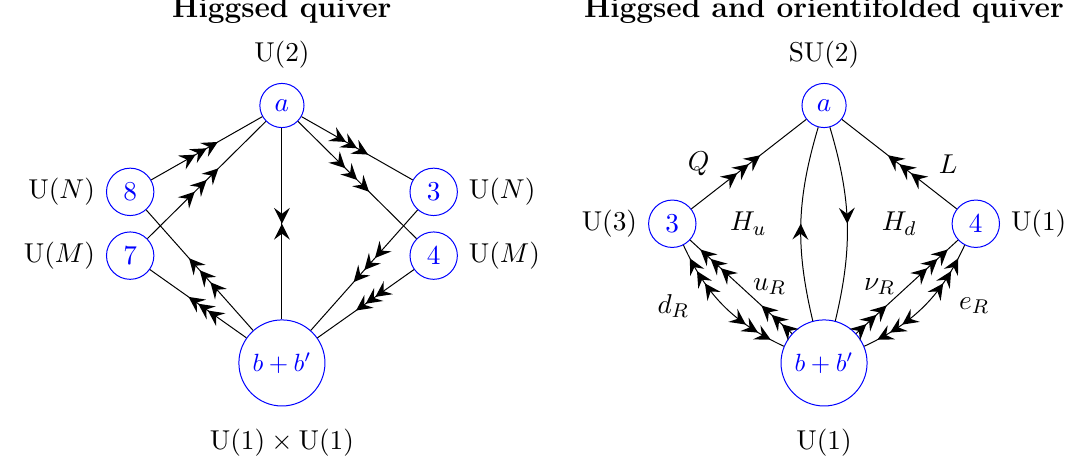
Figure 12 . Left: Higgsed dP 5 quiver diagram for Model II obtained from the quiver in figure 11. Right: orientifolded quiver diagram for N = 3 and M = 1 via the involution (2.30). We find 598 complex scalars in bi-fundamentals between U(2) and one of the U(1) ’s or between the two U(1) ’s. There is no non-chiral matter between either U( N ) or U( M ) and U(2) ( U(1)